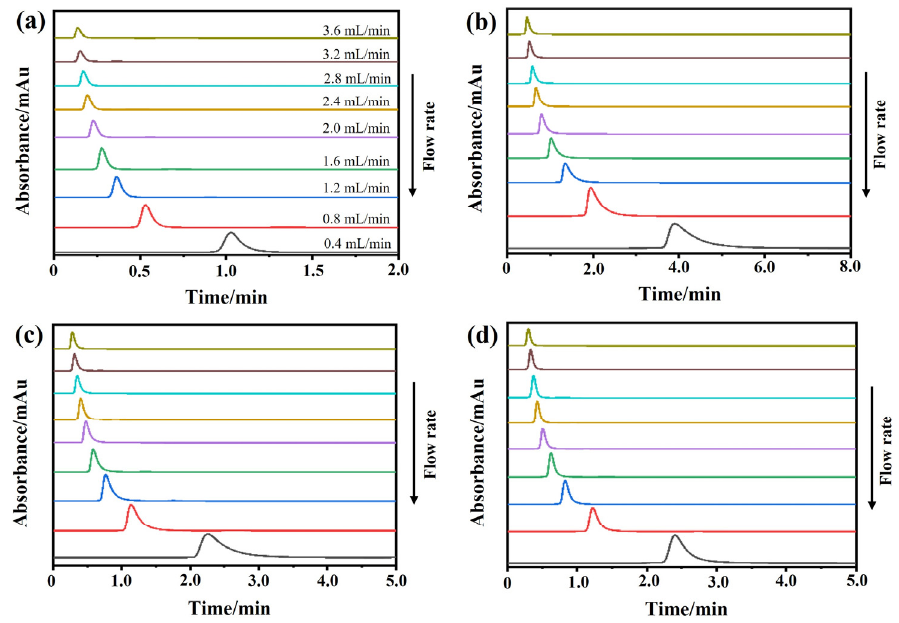
Figure 5. Representative chromatograms. The representative chromatograms of sodium nitrate ( a ), atropine sulfate ( b ), pilocarpine ( c ), and ( − )-scopolamine hydrochloride ( d ) on the M3R-immobilized column at indicated fl ow rates.